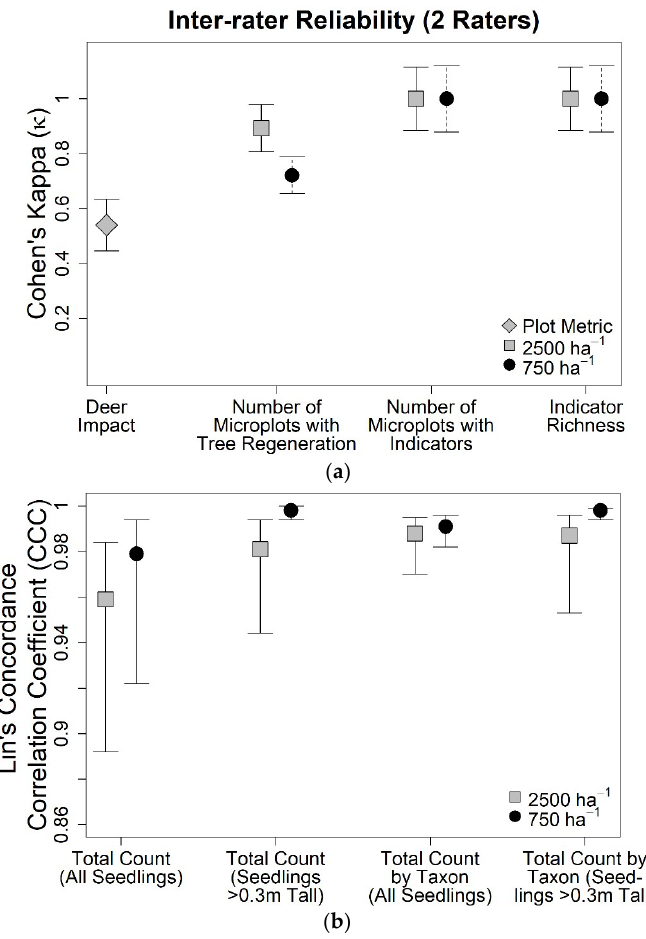
Figure 4. Inter-rater reliability (IRR) assessments of 4 categorical vegetation metrics ( a ) compared with Cohen’s Kappa (κ), and 4 continuous vegetation metrics ( b ) compared with Lin’s concordance correlation coefficient (CCC). Gray squares indicate values for the 1/2500th ha scale, black circles indicate values for the 1/750th ha scale, and the gray diamond indicates a plot-level metric. Dashed and gray lines represent 95% confidence intervals for 1/750th and 1/2500th ha point values, respectively.